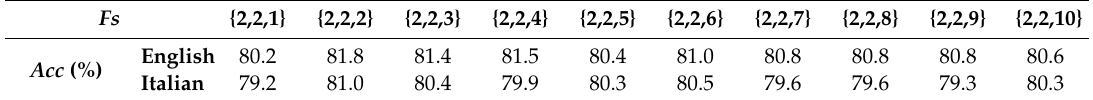
Table 10. Testing accuracy obtained by different filter sizes 1 .